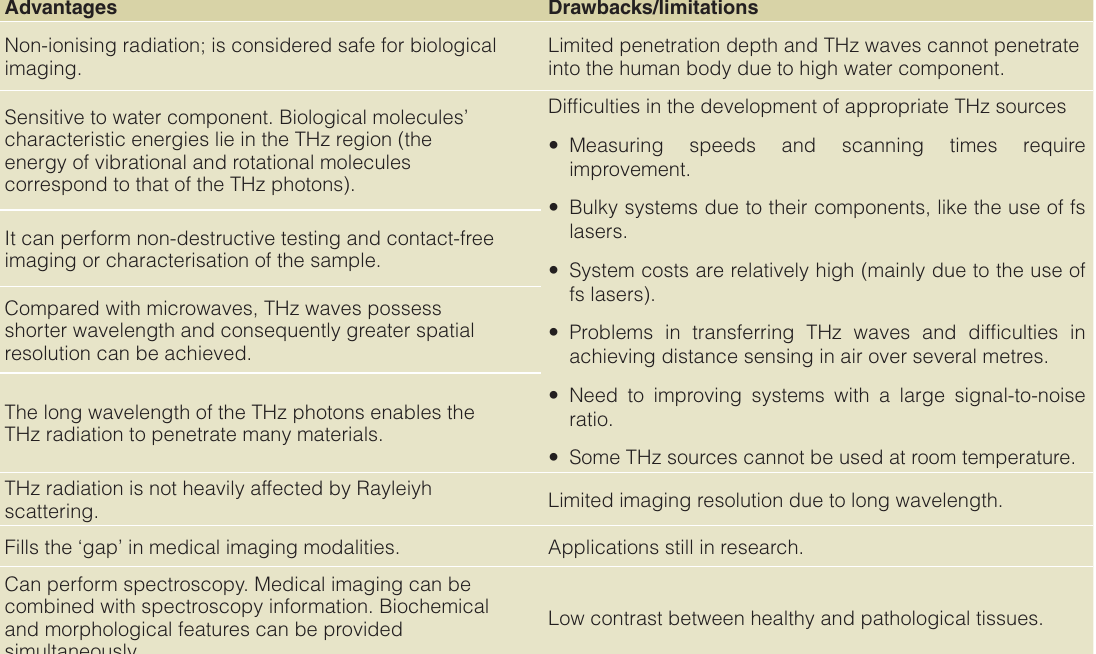
Table 2. Advantages and limitations/drawbacks of THz